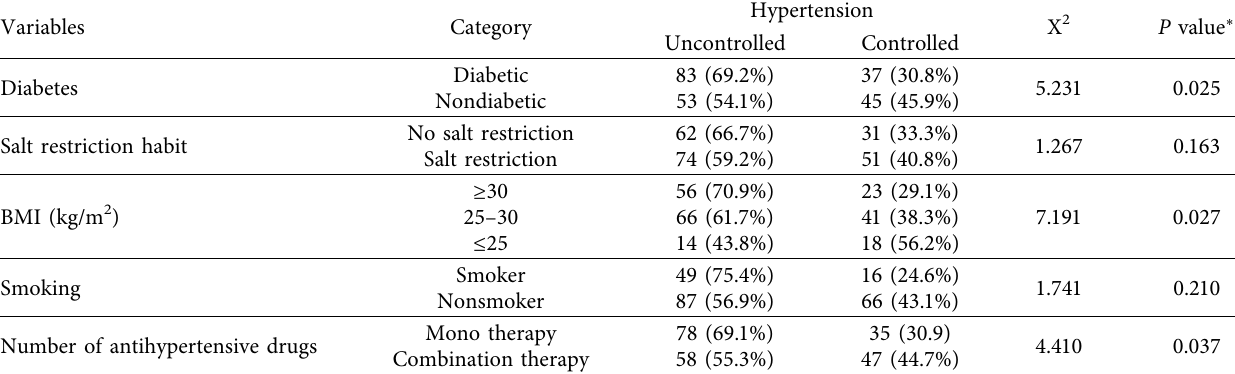
Table 4: Relationship of medical and health variables with HTN control applying the Chi-square test.